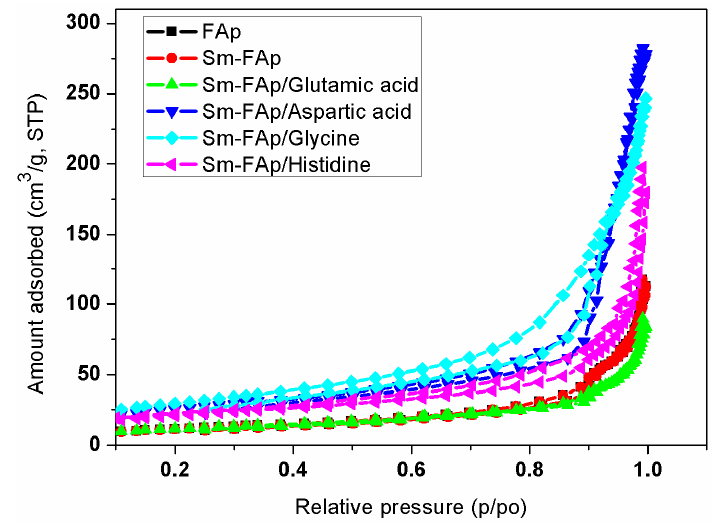
Figure 4. N 2 adsorption/desorption isotherm at 77 K.